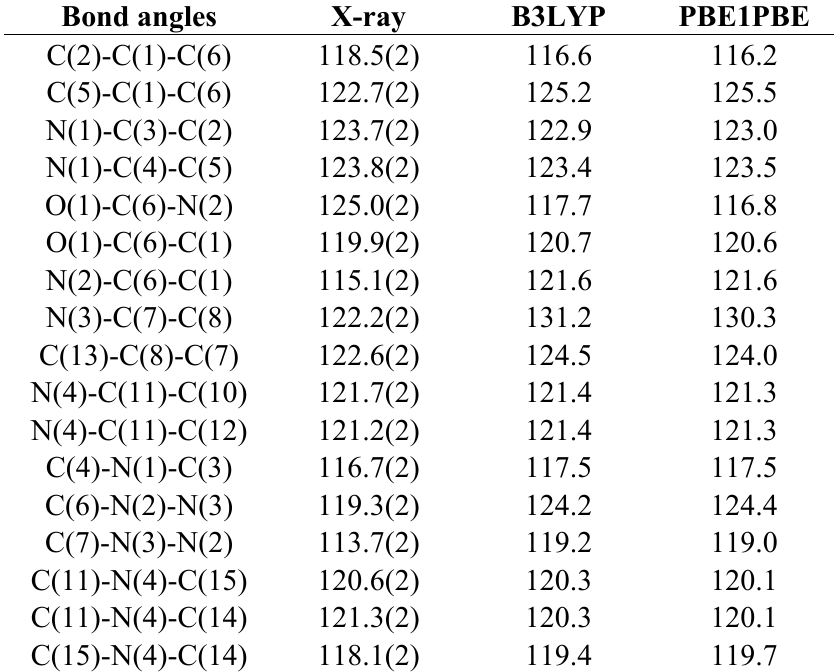
Table 4. Comparison of calculated bond angles (°) for the compound